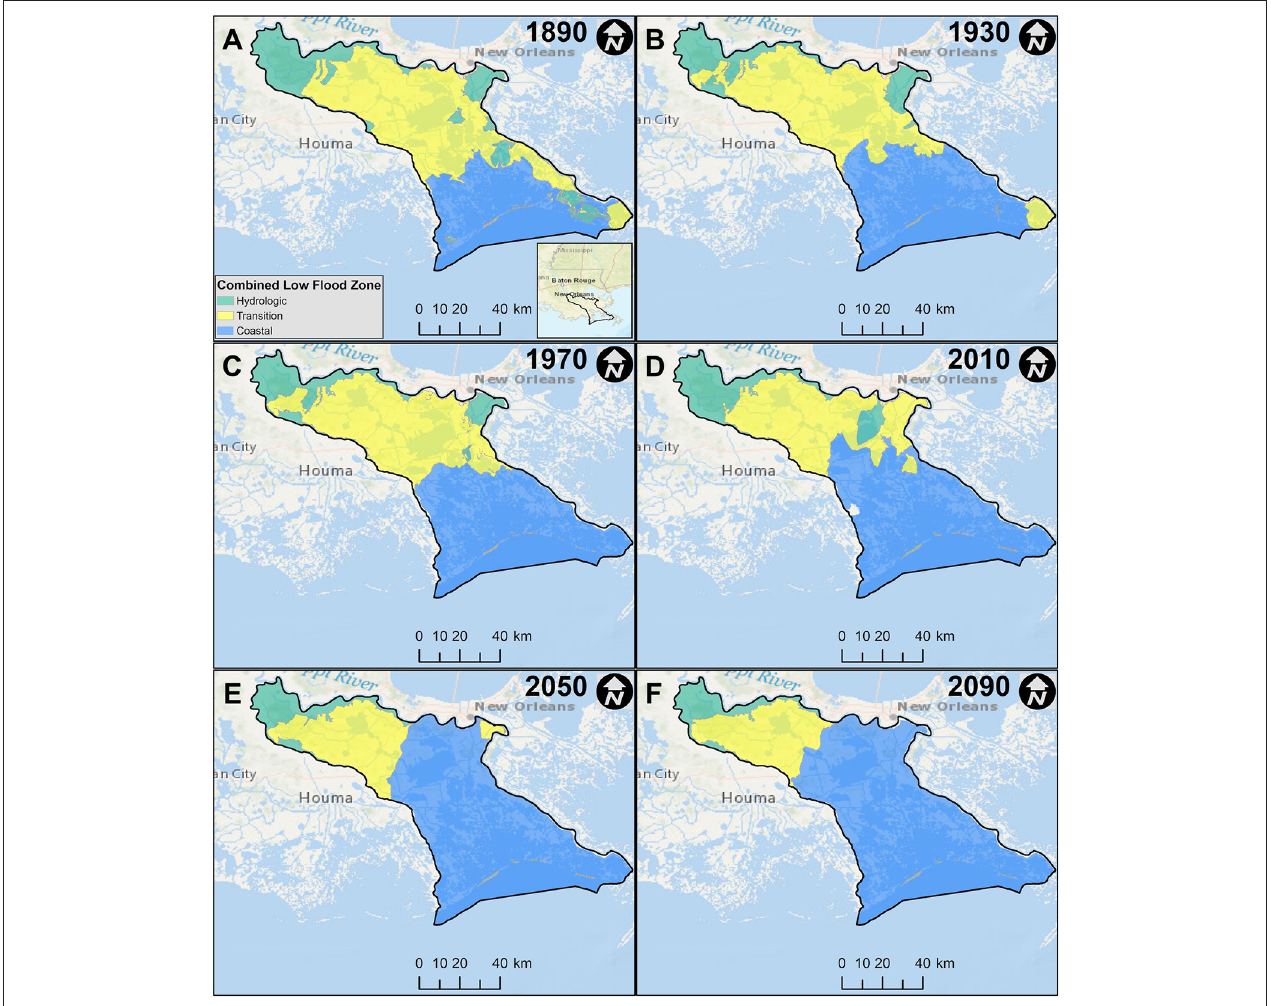
FIGURE 3 | Compound flood hazard zone delineation for the Barataria watershed using low flood events for (A) 1890, (B) 1930, (C) 1970, (D) 2010, (E) 2050, and (F) 2090. Service Layer Credits: Esri, Garmin, GEBCO, NOAA NGDC, OpenStreetMap, and the GIS User